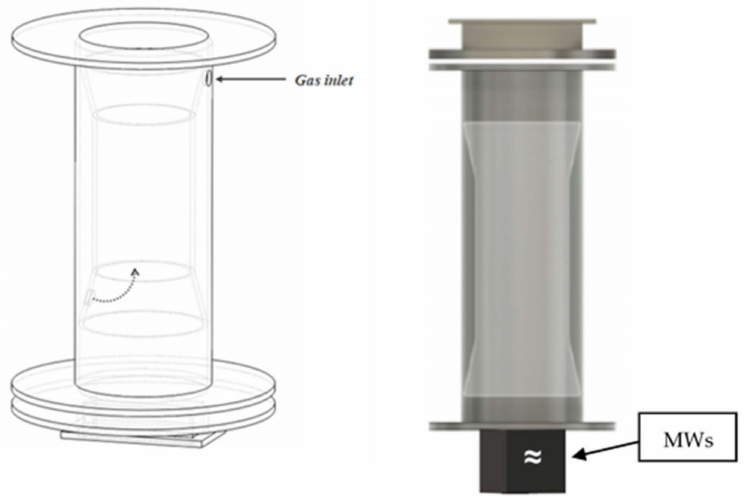
Figure 2. Innovative adsorber